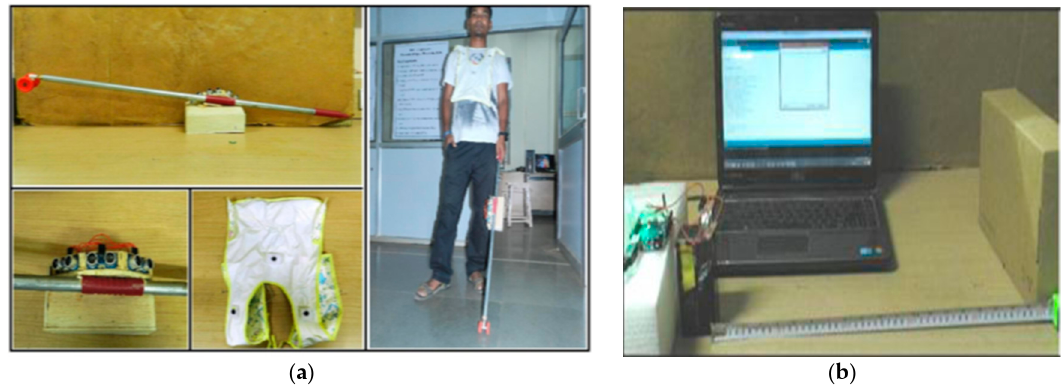
Figure 18. ( a ) The prototype of the device; ( b ) Detection process of the obstacle from 5 cm to 150 cm [38].